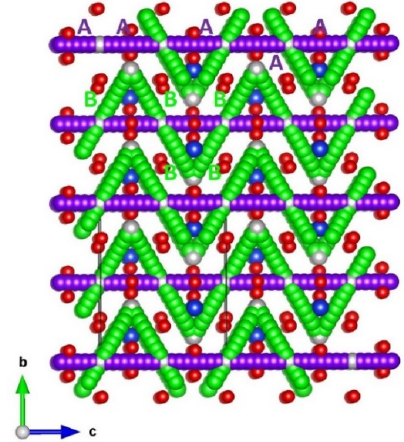
Figure 3. Possible long-range Al vacancy migration paths considered. Green and purple color atoms correspond to different Al hopping trajectories.